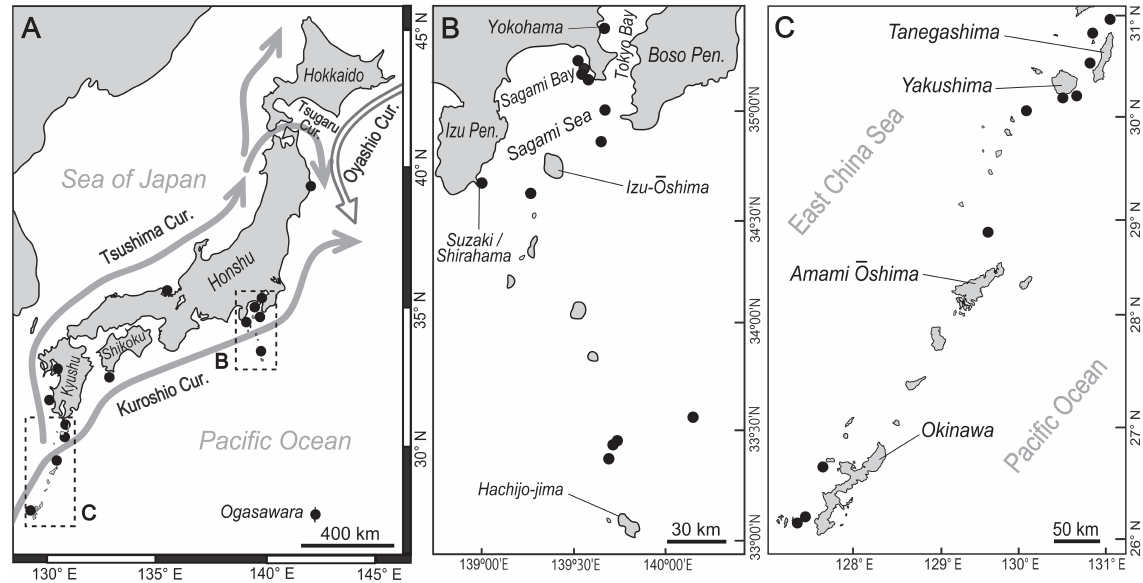
Fig. 1. Maps showing the localities where adeonid bryozoans were collected. A . Collecting localities around Japan. Gray arrows indicate warm currents, the unfilled arrow indicates the cold current. B . Enlargement from previous, showing the localities around Sagami Bay, Sagami Sea, and Hachijo-jima island. C . enlargement from map A, showing the localities along the Nansei islands, from Tanegashima to